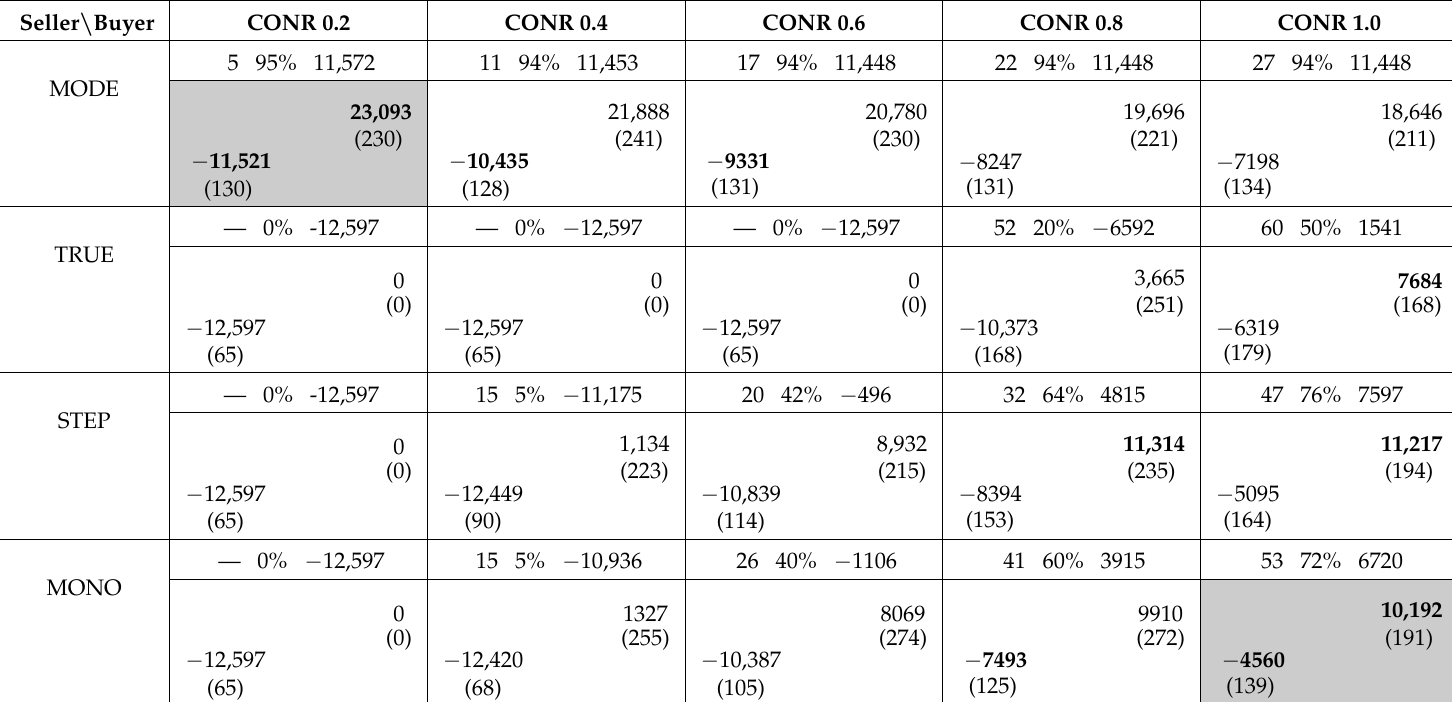
Table 4. Payoff matrix in the mid-risk